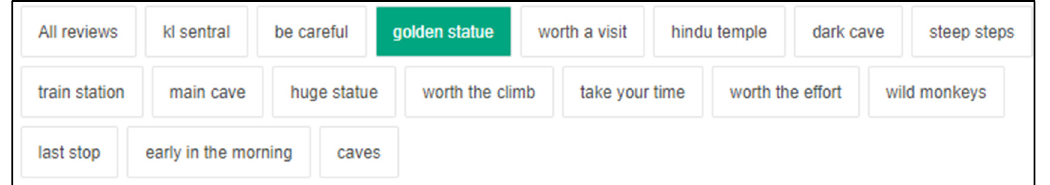
Figure 6. TripAdvisor reviews’ tags for the case study POI, Batu Caves.